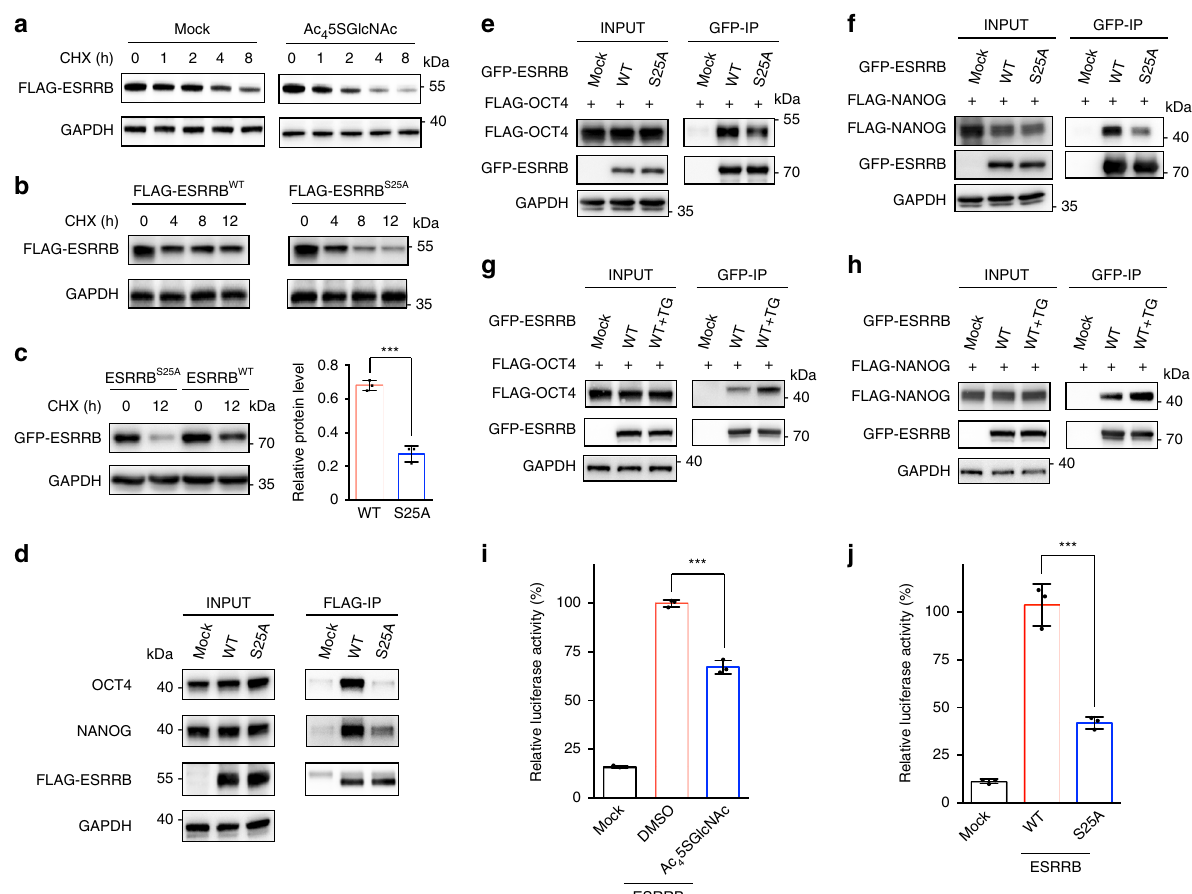
Fig. 4 ESRRB O-GlcNAcylation enhances protein stability, protein-protein interactions and transcriptional activity. a Immunoblots showing expedited degradation of ESRRB upon O-GlcNAcylation inhibition. mESCs expressing FLAG-ESRRB pre-treated with or without Ac 4 5SGlcNAc were incubated with 50 μ M CHX for up to 8 h, during which the expression of FLAG-ESRRB was monitored. b Immunoblots showing mESCs expressing FLAG-ESRRB or FLAG- ESRRB S25A treated with CHX for up to 12 h. c Immunoblots showing HEK293T cells expressing EGFP-ESRRB or EGFP-ESRRB S25A treated with CHX for 12 h. Bar graph showing statistical analysis of the relative protein level of HEK293T cells treated with CHX for 12 h (normalized to that with no CHX). Error bars represent mean ± s.d. *** P < 0.001 (Student ’ s t -test). d Immunoblots showing co-immunoprecipitation of endogenous OCT4 and NANOG with ESRRB in mESCs. mESCs expressing FLAG-ESRRB or FLAG-ESRRB S25A were immunoprecipitated with an anti-FLAG antibody. e , f Immunoblots showing co- immunoprecipitation of OCT4 and NANOG with ESRRB in HEK293T cells. The cells co-expressing FLAG-OCT4 with EGFP-ESRRB or EGFP-ESRRB S25A or co-expressing FLAG-NANOG with EGFP-ESRRB or EGFP-ESRRB S25A were immunoprecipitated with an anti-GFP antibody. g , h Increasing O-GlcNAcylation promoted interactions of OCT4 and NANOG with ESRRB. With the treatment of DMSO or Thiamet-G (TG) for 48 h, HEK293T cells co-expressing FLAG- OCT4 with EGFP-ESRRB or co-expressing FLAG-NANOG with EGFP-ESRRB were immunoprecipitated with an anti-GFP antibody. i Luciferase assay showing reduced ESRRB transcriptional activity upon O-GlcNAc inhibition. j Luciferase assay showing transcriptional activities of WT and S25A mutant ESRRB. In i and j results are shown from three independent experiments. *** P < 0.001 (one-way ANOVA). The anti-GAPDH gels in a – f demonstrate comparable loading. In a – h representative results are shown from three independent experiments. Source data for fi gures a – j are provided as a